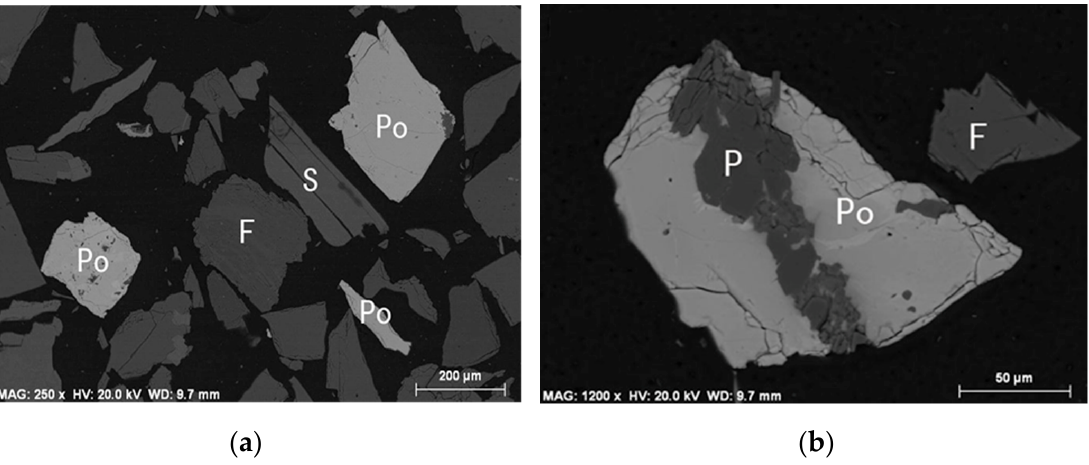
Figure 5. Characteristics of pollucite (Po), albite (F), spodumene (P), and mica (S): ( a ) pollucite occurs as a monomer; ( b ) intergrowth of coarse-grained pollucite and spodumene.